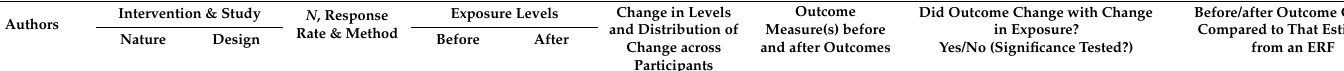
Table 5. New/Closed Infrastructure (Type